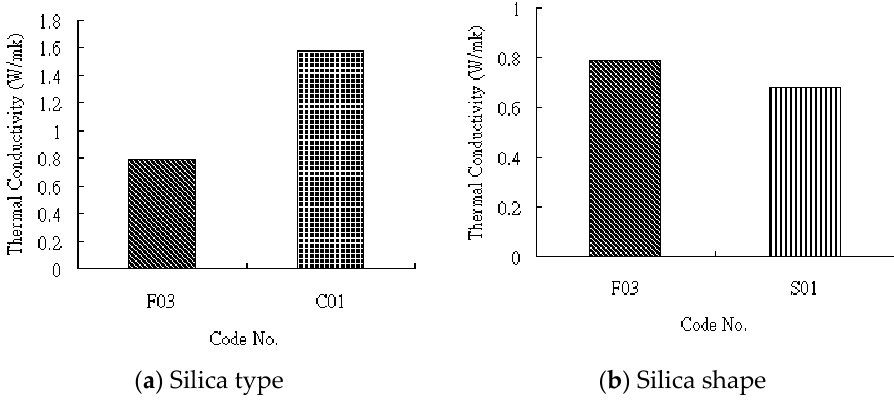
Figure 7. Thermal conductivity of EMCs with silica fillers of different types and shapes.